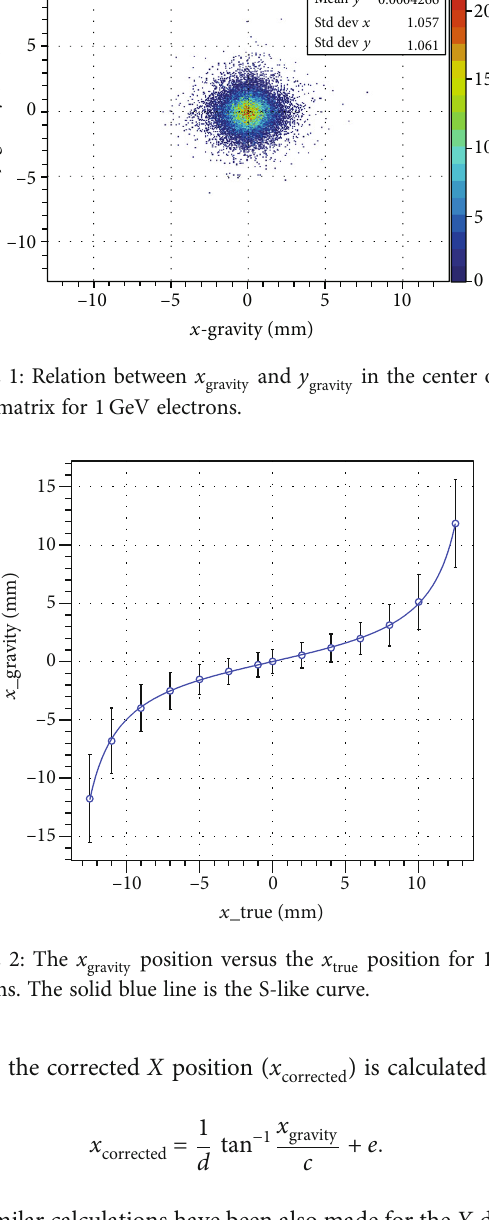
position for 1GeV true